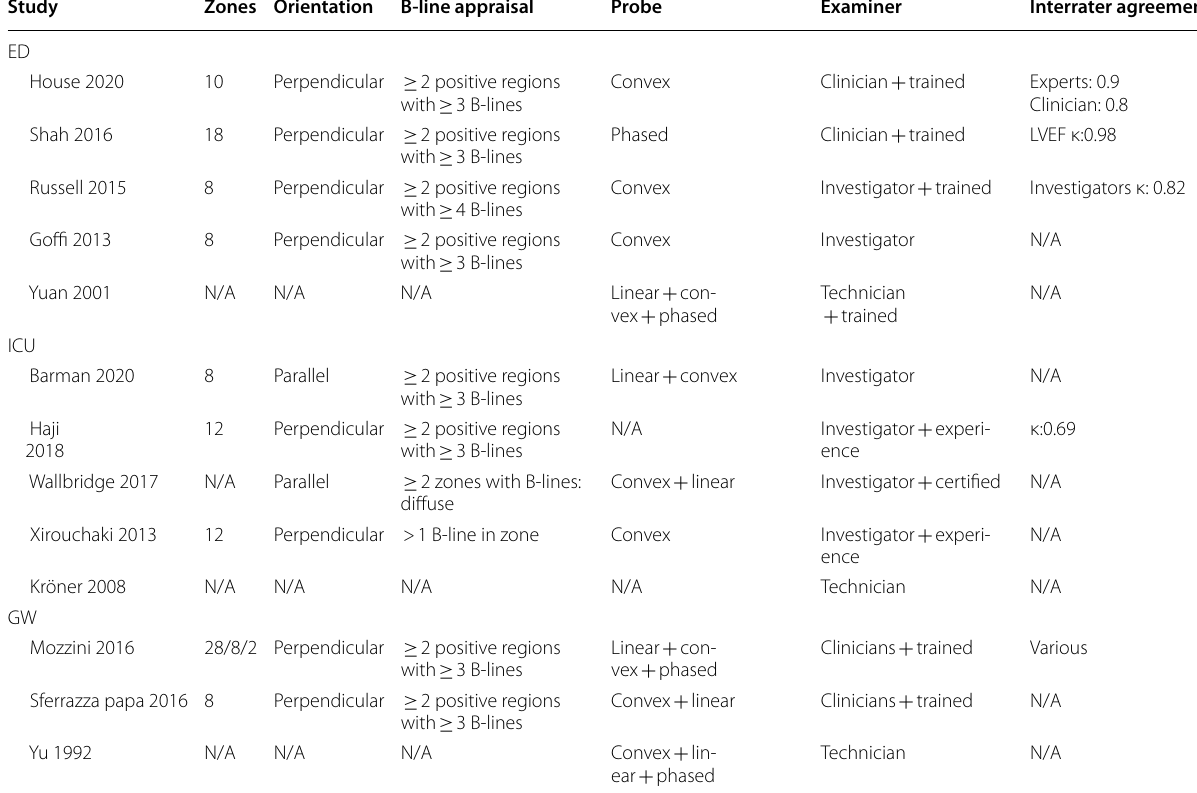
Table 3 Lung ultrasound methodology of included